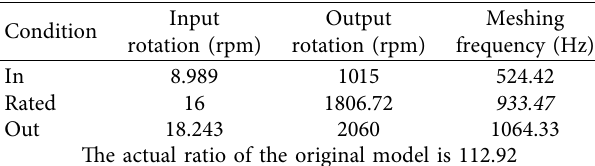
Table 4: Gear mesh frequencies of original parallel-axis helix stage.